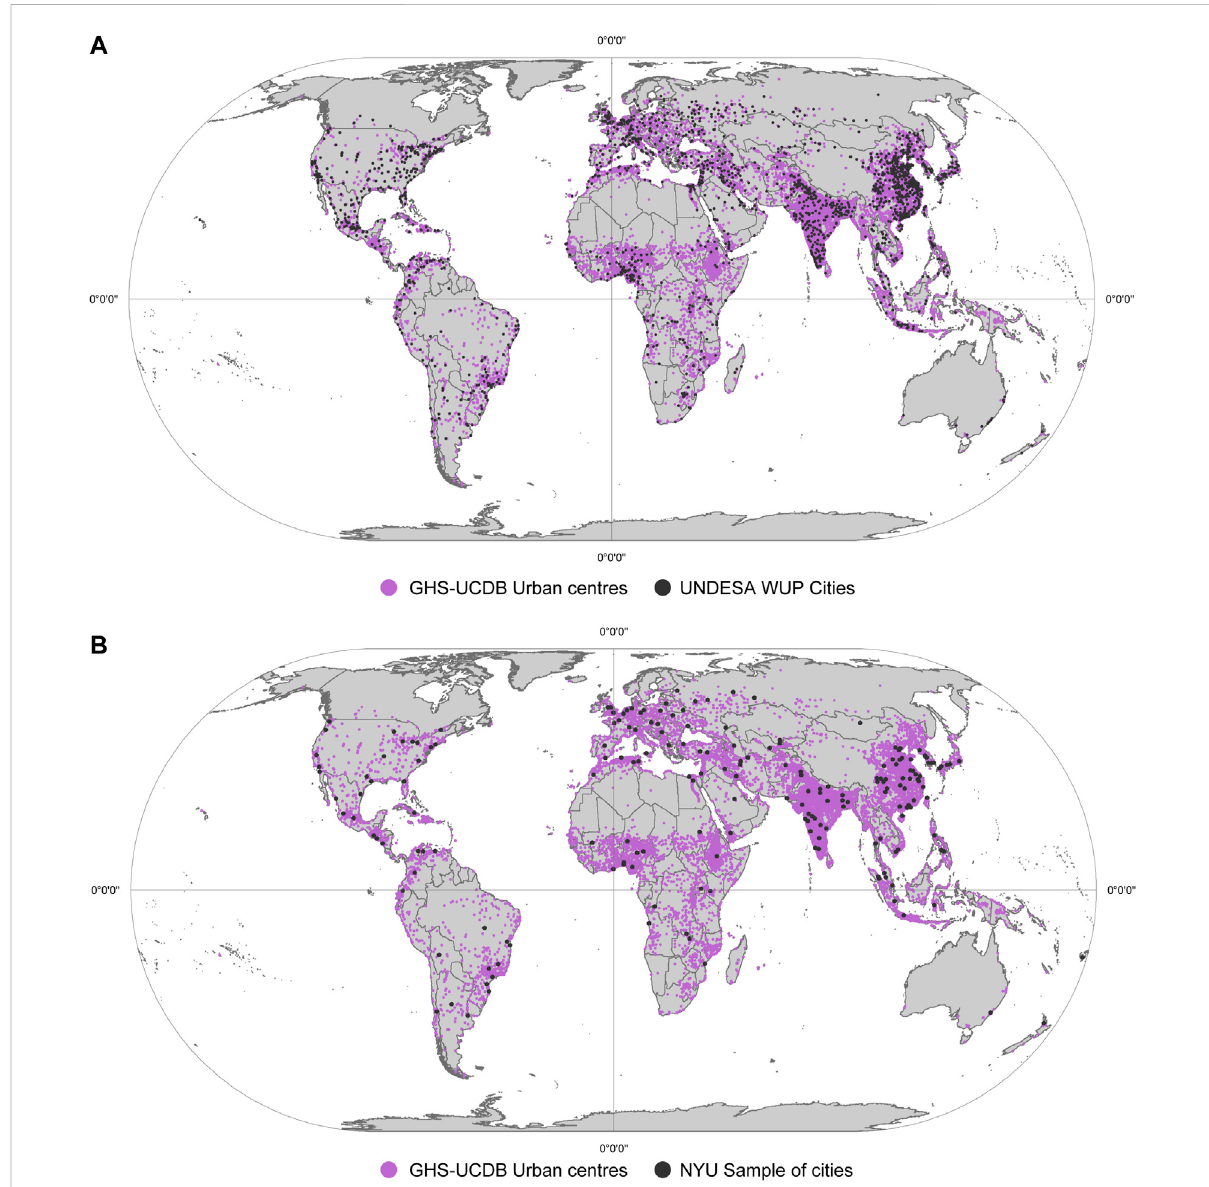
FIGURE 1 Comparison of the geographical distribution of the cities included in the main databases on cities: (A) UNDESA World Urbanization Prospects (2018) and GHS Urban Centre Database (2019); (B) NYU Global Sample of Cities (2016) and GHS Urban Centre Database (2019). Existing datasets on cities vary signi fi cantly in terms of geographical coverage (number of records) and thematic